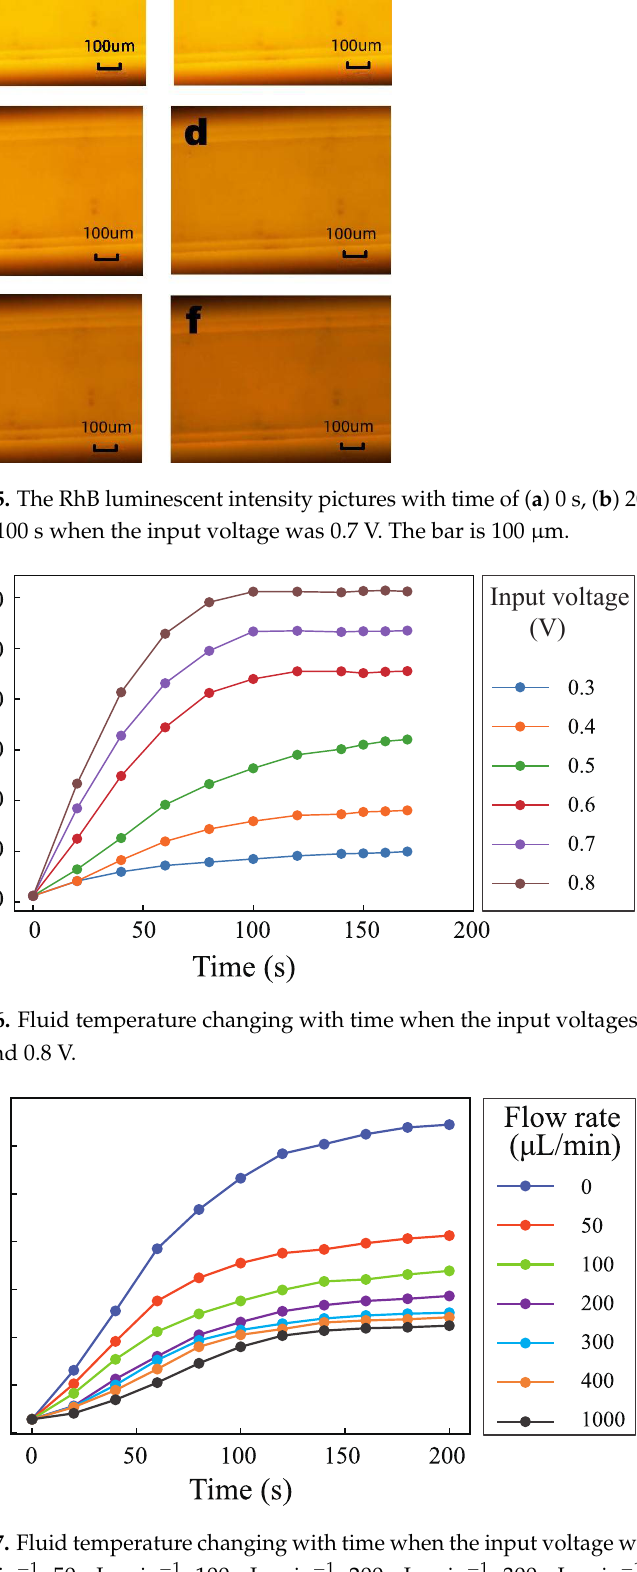
Figure 7. Fluid temperature changing with time when the input voltage was 0.5 V, the flow rates were 0 µ L · min − 1 , 50 µ L · min − 1 , 100 µ L · min − 1 , 200 µ L · min − 1 , 300 µ L · min − 1 , 400 µ L · min − 1 , and 1000 µ L · min − 1 . 23 Figure 8. The highest fluid temperature of the different flow rates when the input voltage was 0.5 V. 154